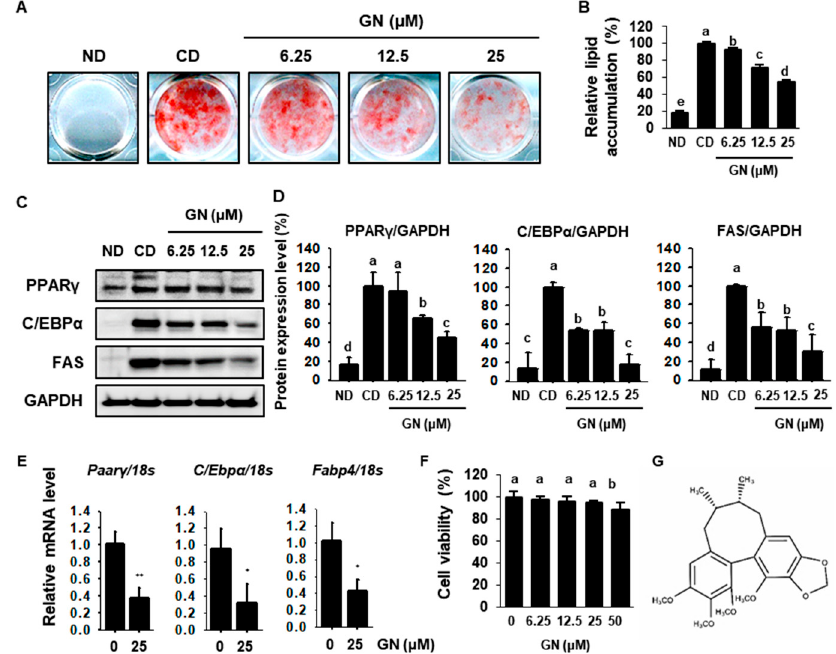
Figure 1. Effects of Gomisin N (GN) on lipid accumulation in 3T3-L1 cells. ( A , B ) Oil red O staining images of 3T3-L1 cells treated with GN for 8 days of differentiation and quantification of Oil red O levels. ( C , D ) Western blotting for the adipogenic proteins peroxisome proliferator-activated receptor gamma (PPAR γ ), CCAAT enhancer-binding protein alpha (C/EBP α ) and fatty acid synthase (FAS) in 3T3-L1 cells and band density quantification. ( E ) Relative mRNA expression levels of the adipogenic genes Ppar γ , C/Ebp α and ap2 were determined by qPCR and normalized to 18S rRNA expression. ( F ) Cell viability of 3T3-L1 cells treated with GN for 24 h, as measured by the XTT assay. ( G ) Chemical structure of GN. Protein data are expressed as mean ± SD ( n = 4). Values with different letters are significantly different, p < 0.05 (a > b > c > d > e). mRNA data are expressed as mean ± SD ( n = 4) and values with different letters indicating significant differences, * p < 0.05, ** p < 0.01. ND;